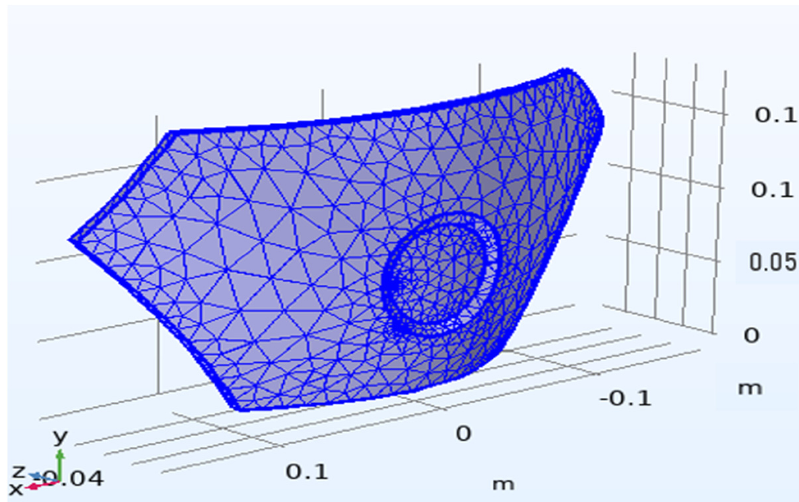
Figure 8. Meshing of Comsol armor in the Johnson-Cook model.